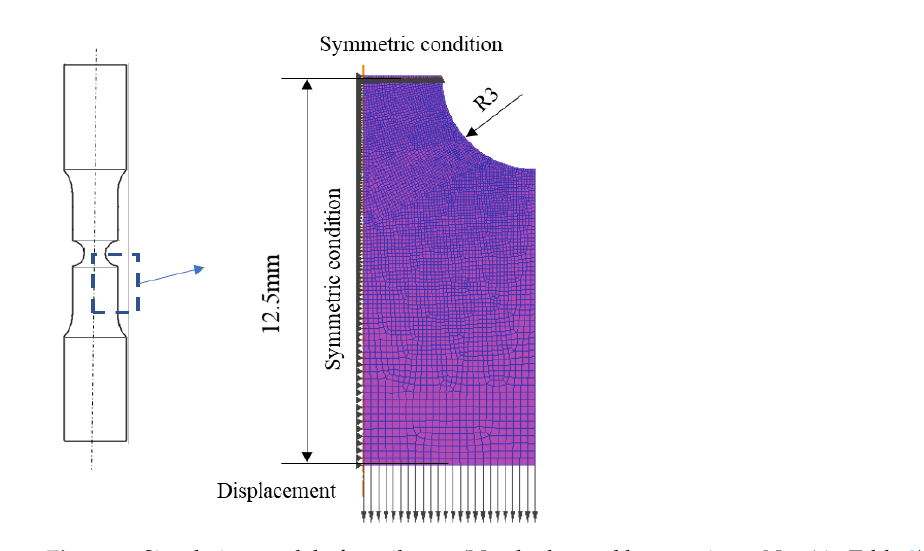
Figure 7. Simulation model of tensile test (Notched round bar specimen No. 4 in Table 2).